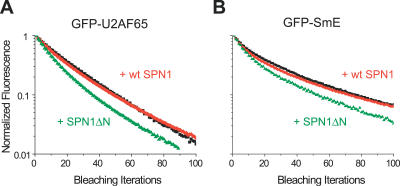
Expression of SPN1ΔN Affects the Mobility of Splicing Proteins in Living CellsFLIP experiments were performed on cells expressing GFP-U2AF65 (A) and GFP-SmE (B) together with the wt (+wt SPN1, red curves) or the dominant-negative mutant (+SPN1ΔN, green curves) forms of snurportin1. The fluorescence decay was analyzed over nuclear speckles. The results obtained for GFP-U2AF65 and GFP-SmE in cells that were not transfected with any SPN1 construct are also shown (black curves). Each decay curve corresponds to a pool of three independent experiments, with ten different cells analyzed per experiment.